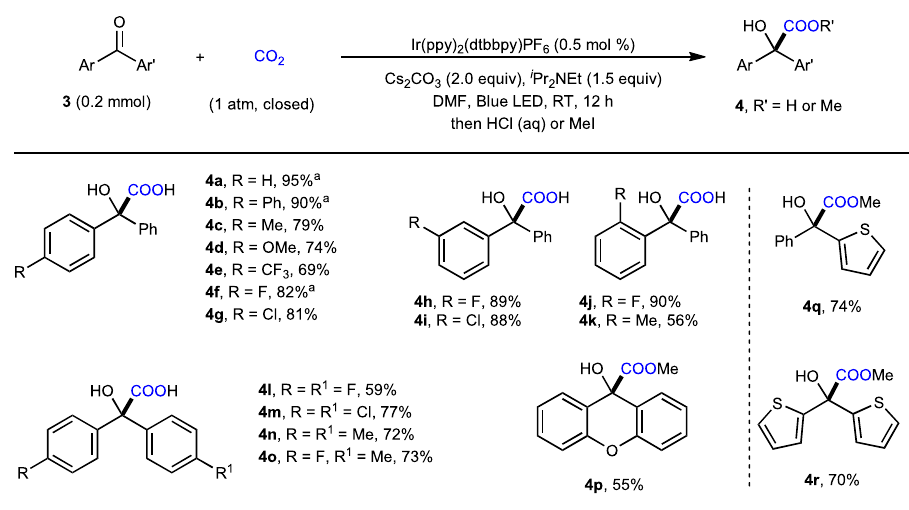
Fig. 5 Substrate scope of diaryl ketones. Reaction condition: ketones (0.2 mmol), Ir-catalyst (0.001 mmol), Cs 2 CO 3 (0.4 mmol), i Pr 2 NEt (0.3 mmol), DMF (2 mL), isolated yields of corresponding carboxylic acids, or methyl esters 4 are shown. a i Pr 2 NEt (1.0 equiv).